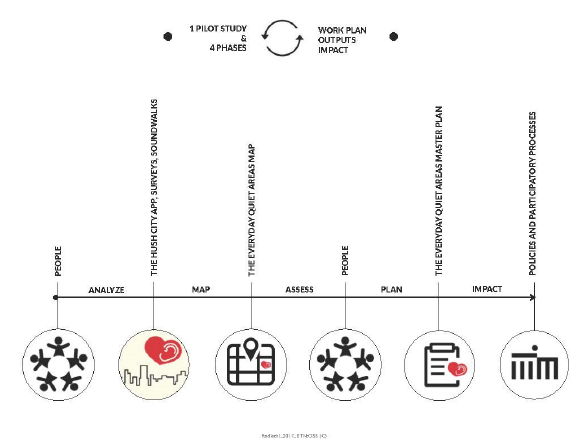
Figure 1: Diagram illustrating the workflow, the outputs and the expected impact of the “open source soundscapes”